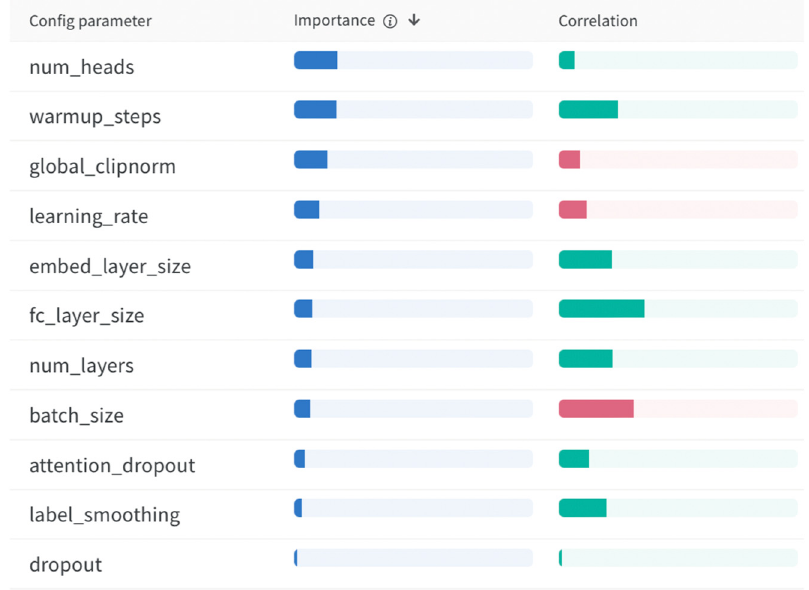
Figure 3. Parameter importance chart.